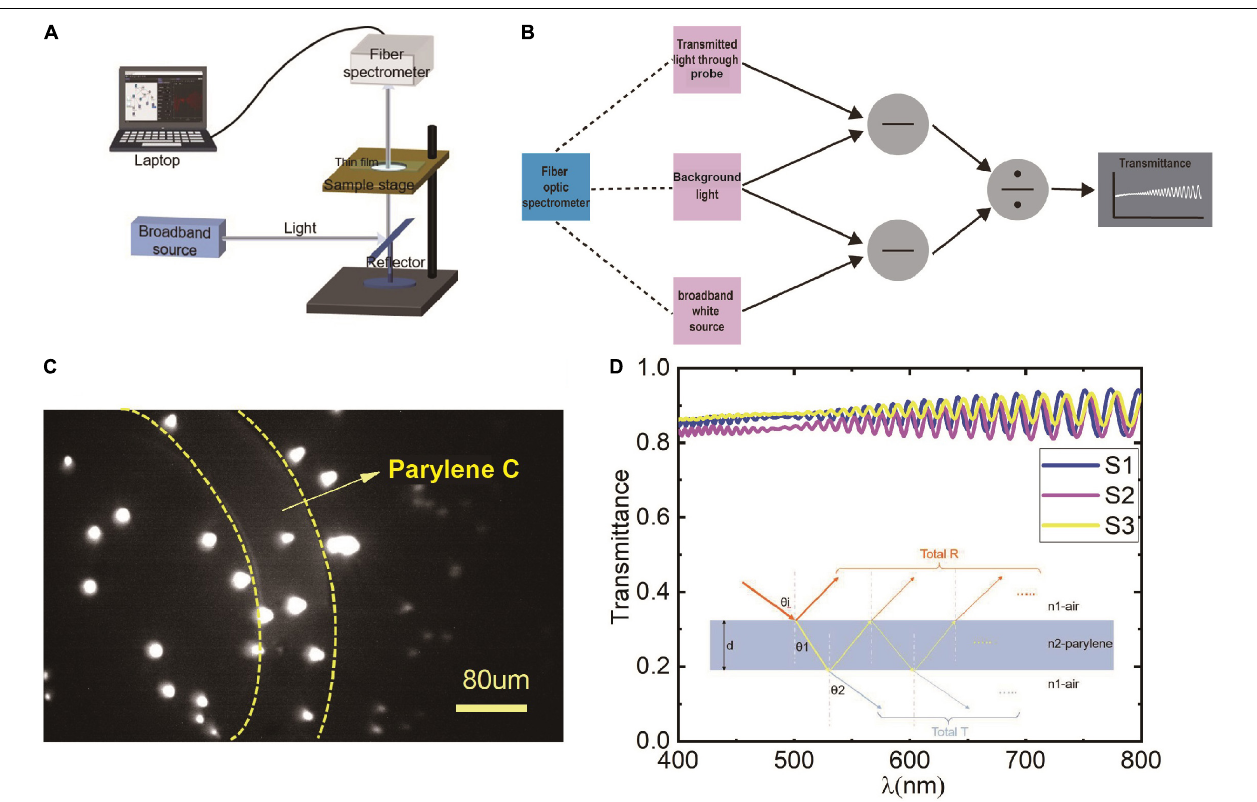
FIGURE 2 | (A) The schematic diagram of the transparency measurement; (B) the calculation schematic diagram of the light transmittance of the corresponding software; (C) fluorescent microspheres imaging results by miniscope taped with a hollowed electrode probe ( ∼ 9 µ m) in vitro , the region between the yellow dotted lines indicates lens taped with Parylene C, the other area indicates imaging without Parylene C; and (D) the calculated light transmittance of three samples, S1, S2, S3, respectively. The result of each sample is the average of three transparent areas. The inset indicates the light transmission path at the interface of air and